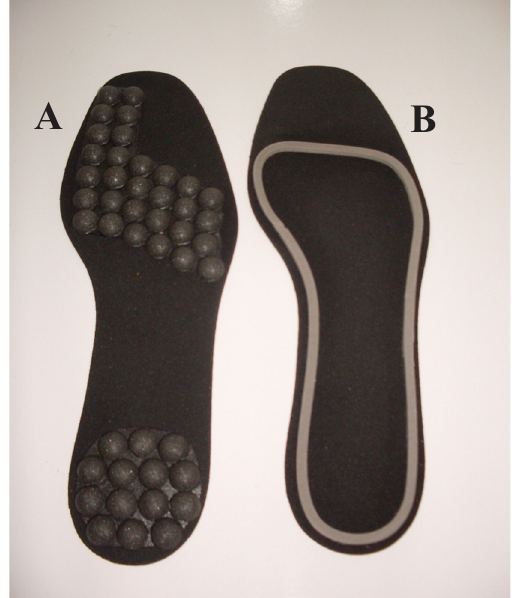
Figure 1. Insoles made for the additional somatosensory information: A - Insole with half-spheres; B - Insole with a raised ridge around the foot perimeter.